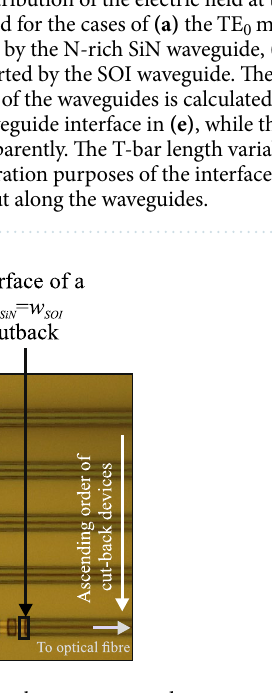
Figure 3. Microscope image of the cut-back structures used to measure the coupling loss between the N-rich SiN and the SOI waveguide for the case of varying interface